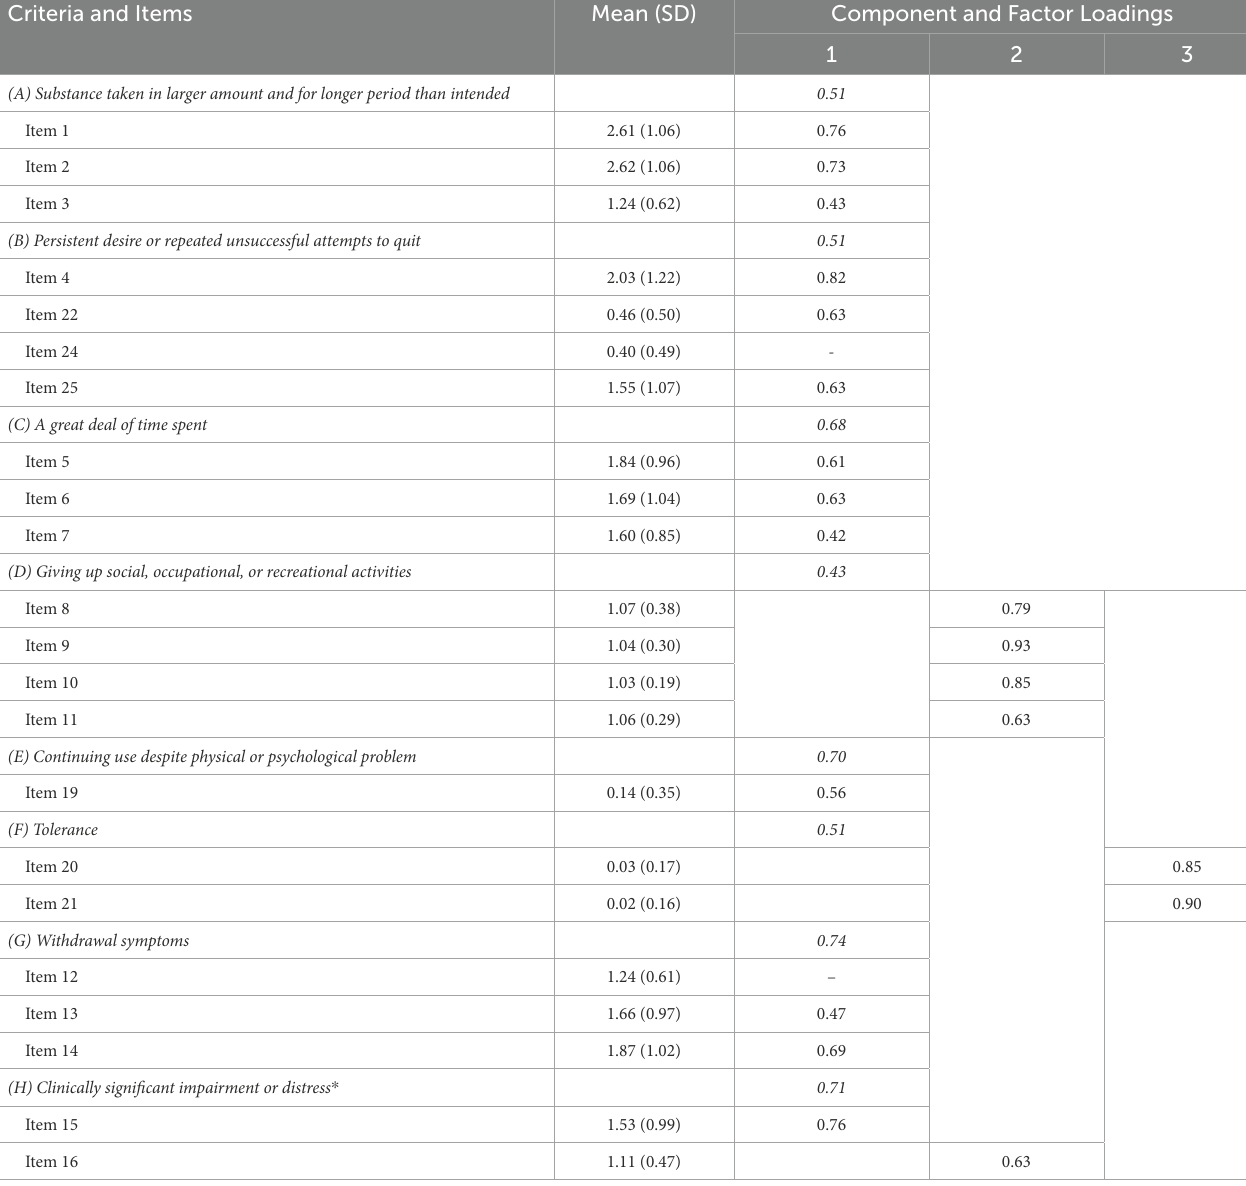
TABLE 2 Descriptive statistics, component matrix, and factor loadings for items and criteria (bolded) of the Finnish version of Yale Food Addiction Scale. Criteria and